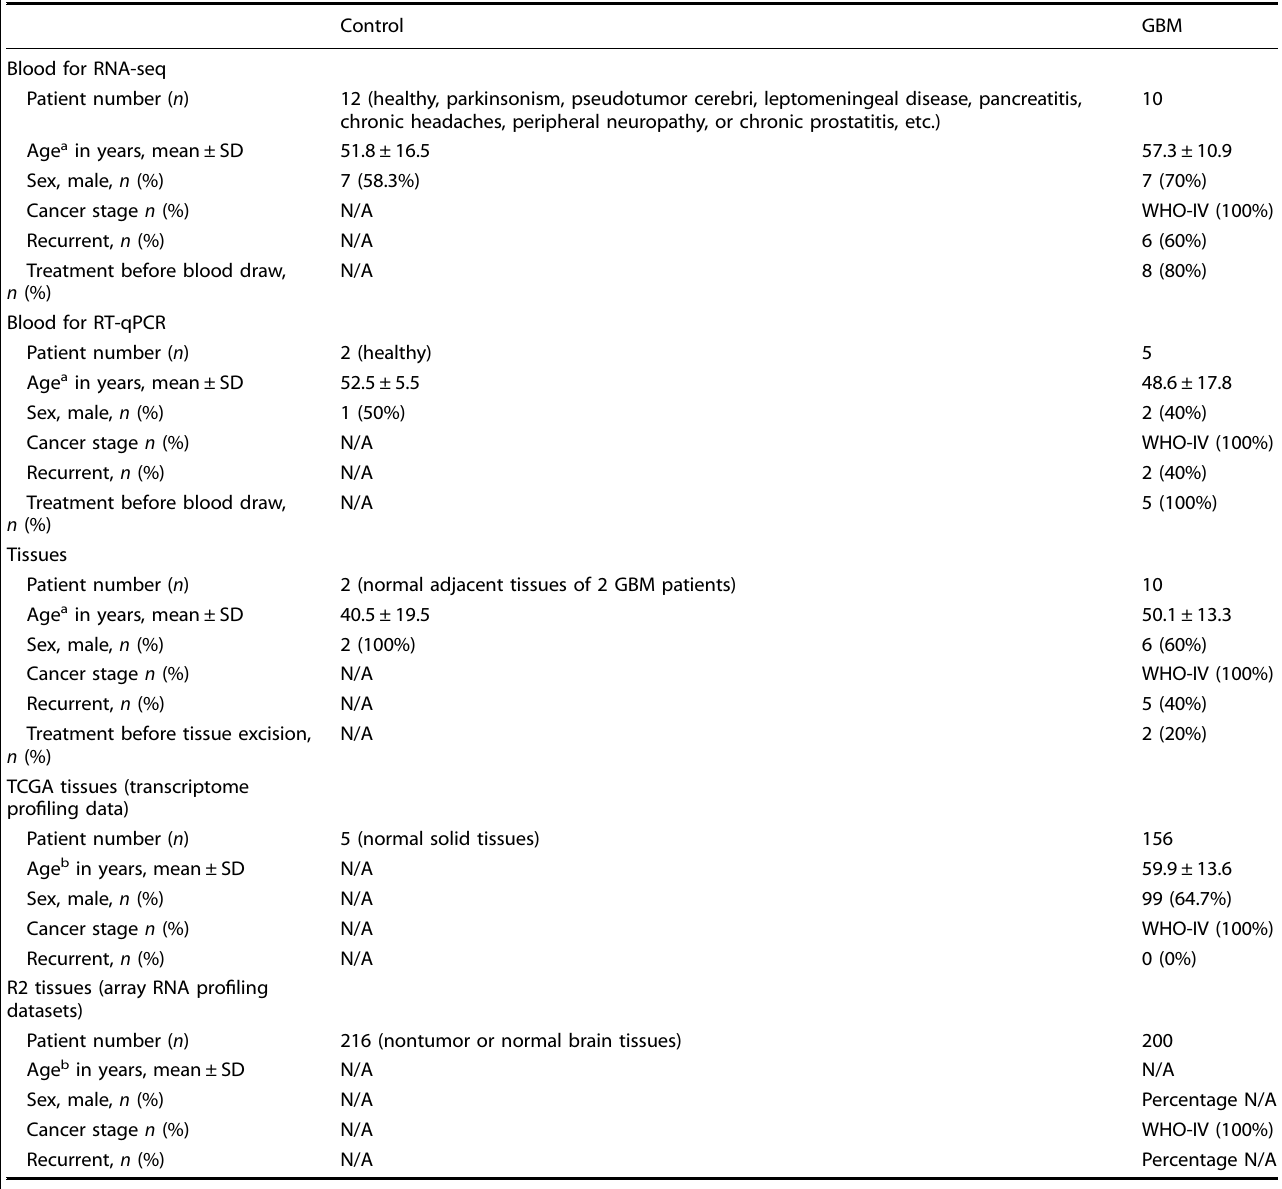
controls and 355 tumor tissues (Table 1), we present WBGR as a useful and advantageous approach for whole blood-based GBM biomarker mining. Its key merits in blood transcriptome analysis include the improvement of detection sensitivity, the ef fi cient enrichment of informative reads towards DGE analysis, and the retention of high expression concordance of non-globin genes after GR. These values allowed us to comprehensively analyze DGE in GBM blood and to distinguish blood samples of GBM patients discern the difference between three males and eight females by GR in a blood microarray assay 24 . Shin et al. subsequently showed the technical and biological bene fi t of GR in the RNA-seq transcriptome pro fi le of human peripheral blood 22 . GR is a critical